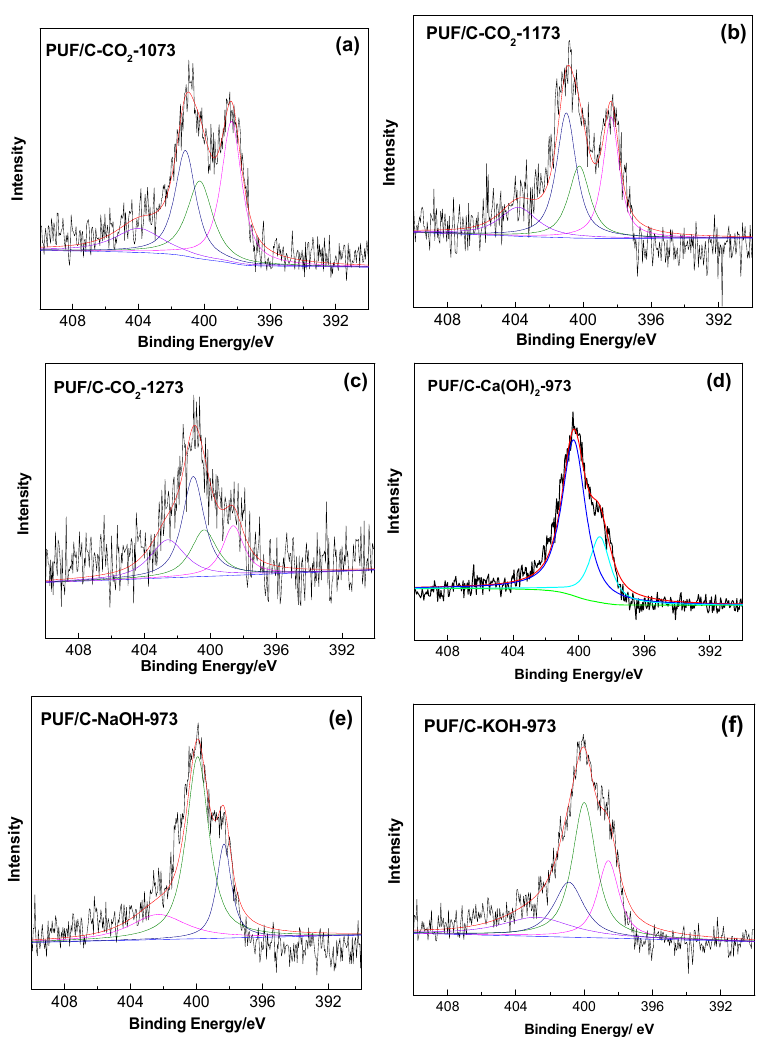
Figure 5. XPS N 1s spectra of PUF/C-CO 2 -1073 ( a ), PUF/C-CO 2 -1173 ( b ), and PUF/C-CO 2 -1273 ( c ), PUF/C-Ca(OH) 2 -973 ( d ), PUF/C-NaOH-973 ( e ), and PUF/C-KOH-973 ( f ).